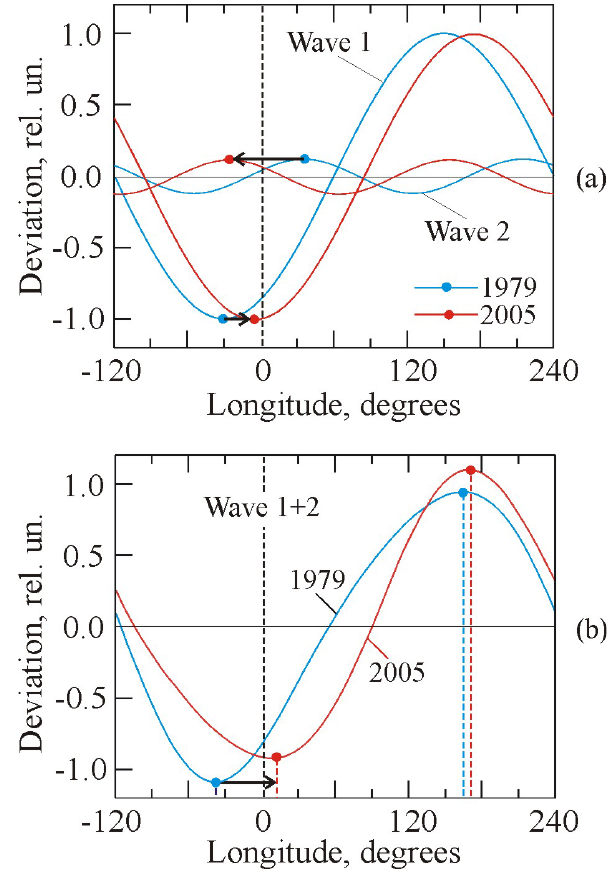
Fig. 10. (a) Initial (1979, blue curves) and final (2005, red curves) longitudinal position of wave 1 and 2 at 65 ◦ S, and (b) their su- perposition, which demonstrates the long-term stability of the wave ridge and eastward shift of the wave